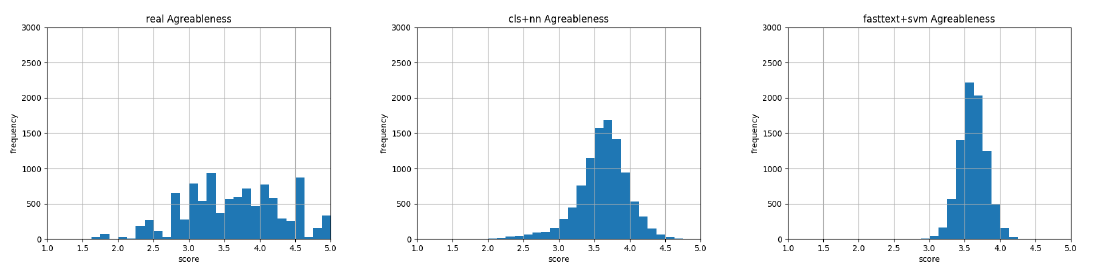
Figure 9. Agreeableness: Histograms representing data distribution of gold standard on the left, our model result in the middle, and previous state of the art by Carducci et al. [8] on the right.